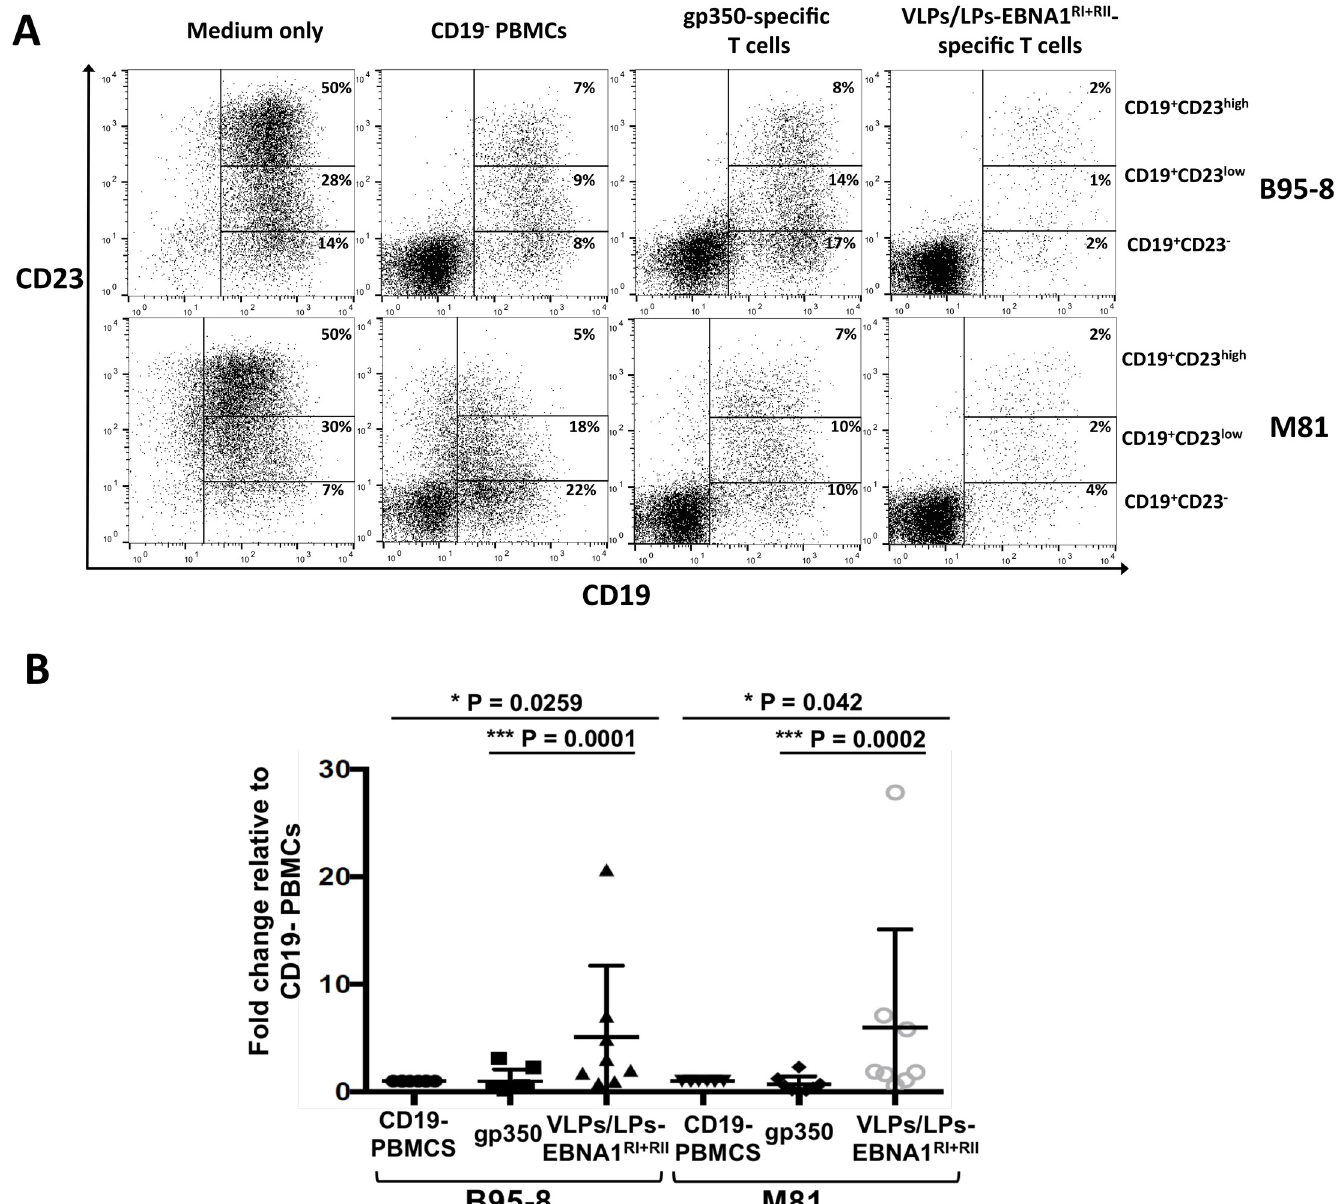
Fig 4. VLPs/LPs-EBNA1 RI+RII -specific T cells prevent the outgrowth of B95-8- and M81-infected B cells. PBMCs from eight unhaplotyped EBV-positive donors were stimulated with gp350 or VLPs/LPs-EBNA1 RI+RII as described in Fig 3, and then cocultured with primary B cells that were infected with B95-8 or M81. In parallel, the infected B cells were cultured in medium only or with CD19 - PBMCs. After 15 days, ex vivo cultures were stained for CD19 and CD23 and then analysed by flow cytometry. (A) Representative flow cytometry data from eight donors. The percentage of CD19 + CD23 - , CD19 + CD23 low and CD19 + CD23 high B cells in ex vivo cultures are shown. (B) A summary of data obtained from eight donors. The percentage of CD19 + CD23 + B cells in all cultures are expressed relative to the percentage of CD19 + CD23 + B cells in the presence of CD19 - PBMCs. Statistical analysis was performed using a two-tailed student t-test. Only P values lower than 0.05 are